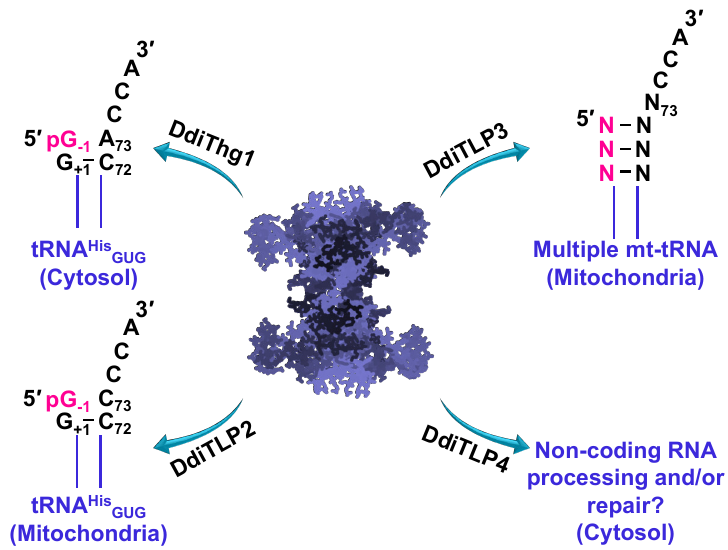
Figure 5. Non-redundant physiological roles for Thg1 and Thg1-like proteins (TLPs) in Dictyostelium discoideum tRNA 5 (cid:48) -editing. DdiThg1 catalyzes cytosolic tRNA His maturation by incorporating G − 1 across from A 73 . DdiTLP2 catalyzes mitochondrial tRNA His maturation by incorporating G − 1 across from C 73 . DdiTLP3 catalyzes mitochondrial tRNA 5 (cid:48) -editing by repairing 5 (cid:48) -truncated tRNAs